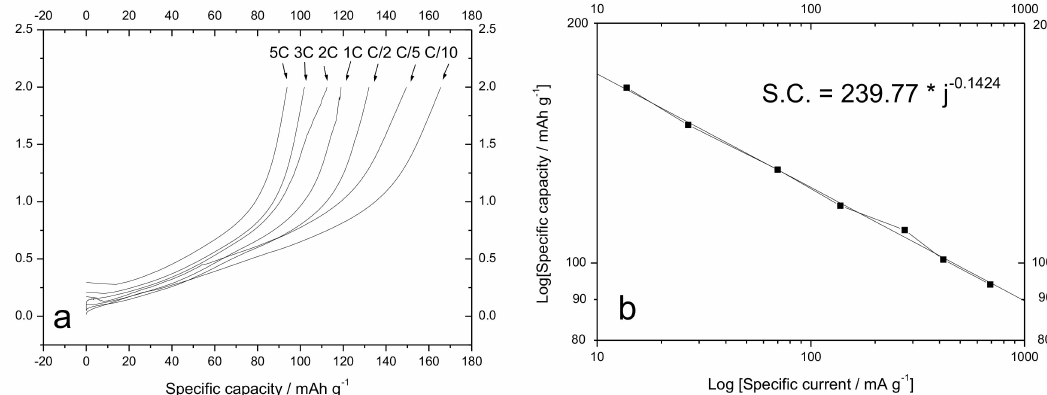
Figure 9. ( a ) Voltage profiles for the Sn-RGO-based electrode recorded at various charge rates as a function of the specific capacity. The charge rates are reported in the figure. ( b ) Log–log plot of the specific capacity as a function of the specific current. The equation inside the graph shows the result of the linear